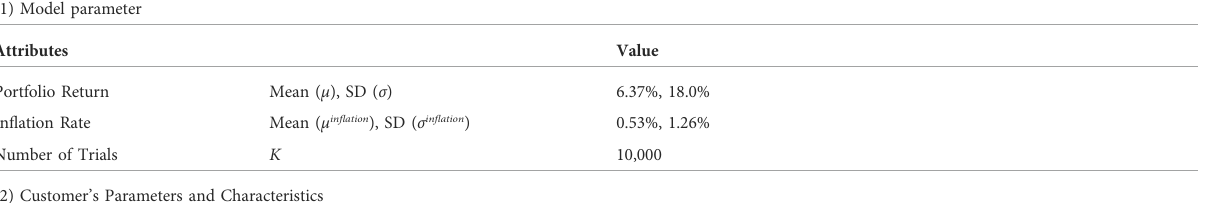
TABLE 1 Parameter settings and Customer ’ s